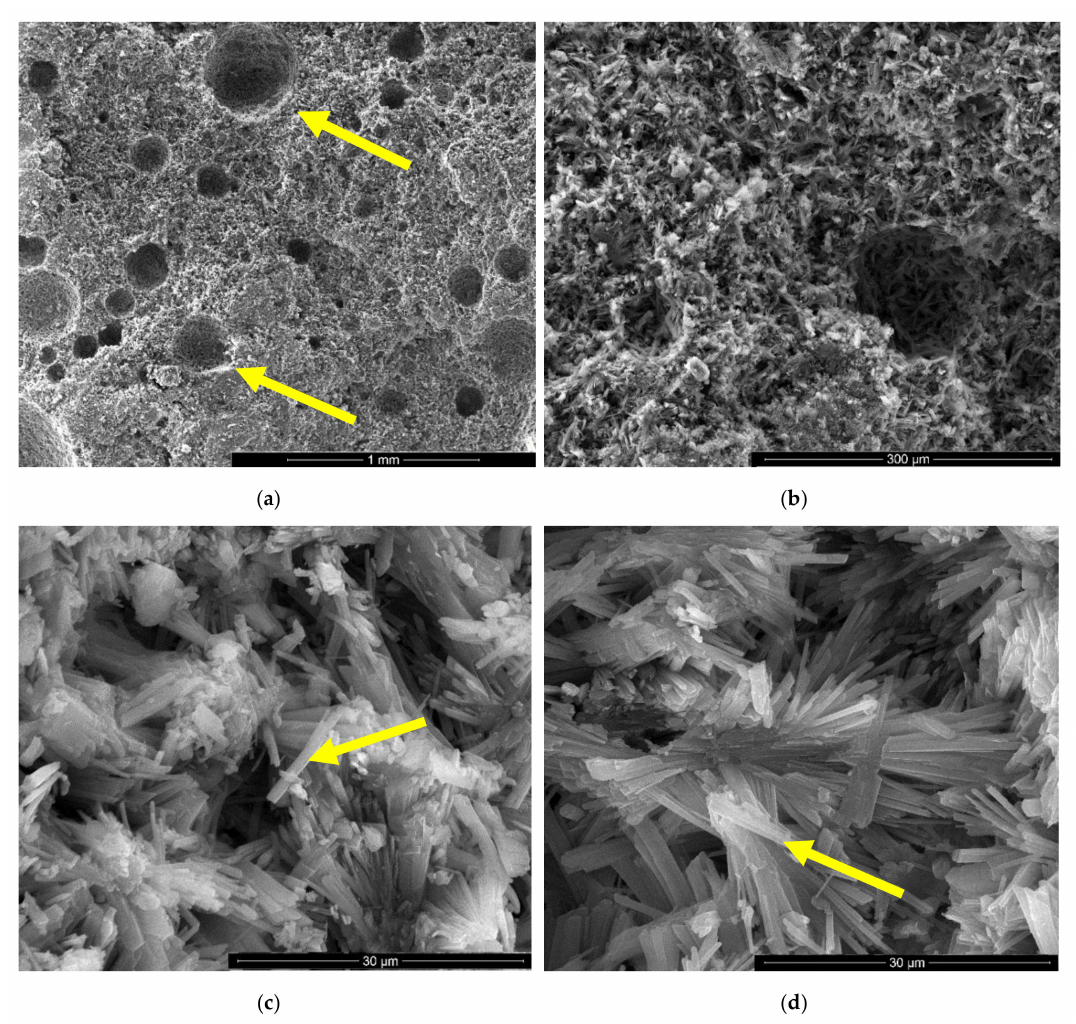
Figure 5. SEM images of gypsum binder with HEMC (IC) after 7 days of hardening in air with various magnifications: ( a ) × 100; ( b ) × 500; ( c ) × 5000; ( d ) ×